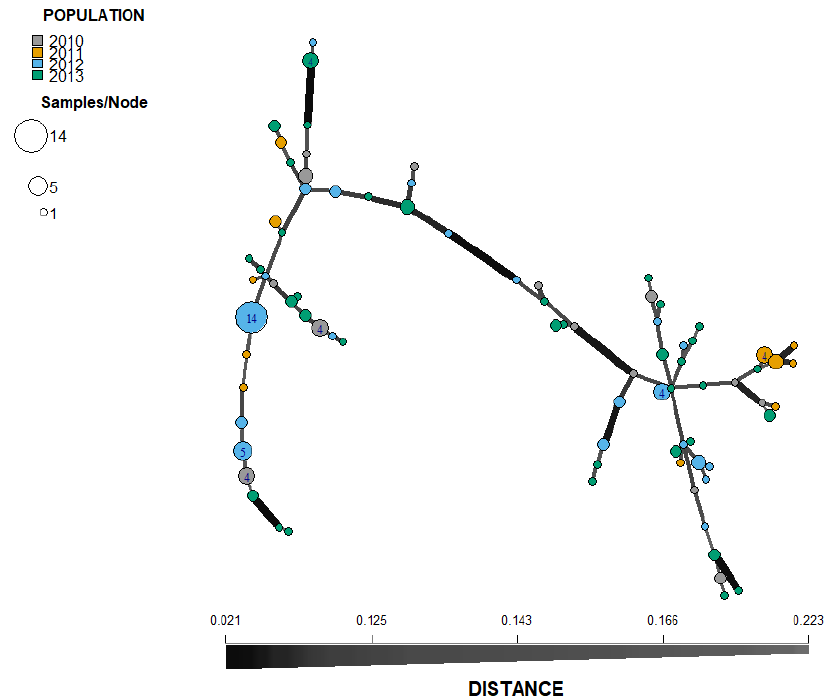
Figure 6. A discriminant analysis of the principal components (PC) scatterplot showing clustering of P. infestans isolates according to years (non-clone corrected). Scatterplots represent the distribution of individuals along the first two linear discriminants. Clusters representing each year are indicated by the color-coded ellipses. Dots represent isolates (in each population). The cross-validated number of the PCs used for the discriminant analysis is shown in the bar plots on the top left of the scatterplot. Indicated at the bottom right corner is the discriminant analysis eigenvalues, respectively. A total of 17 PCs explained 99.4% of the variation.